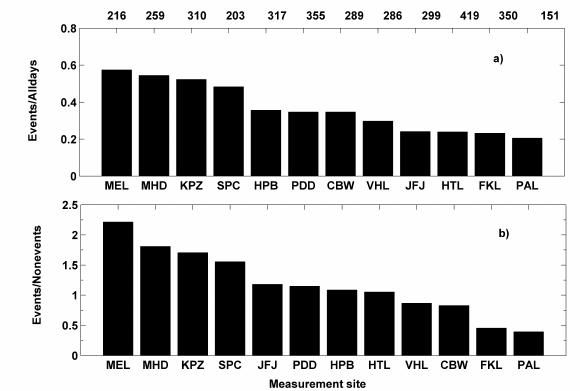
Fig. 3. (a) The fraction of NPF event days relative to the number of all the days and (b) event to non-event day number ratio on each measurement site during the EUCAARI field measurements 2008–2009. The site name abbreviations are listed in Table 1. The numbers above the figure refer to the number of days included in the analysis.